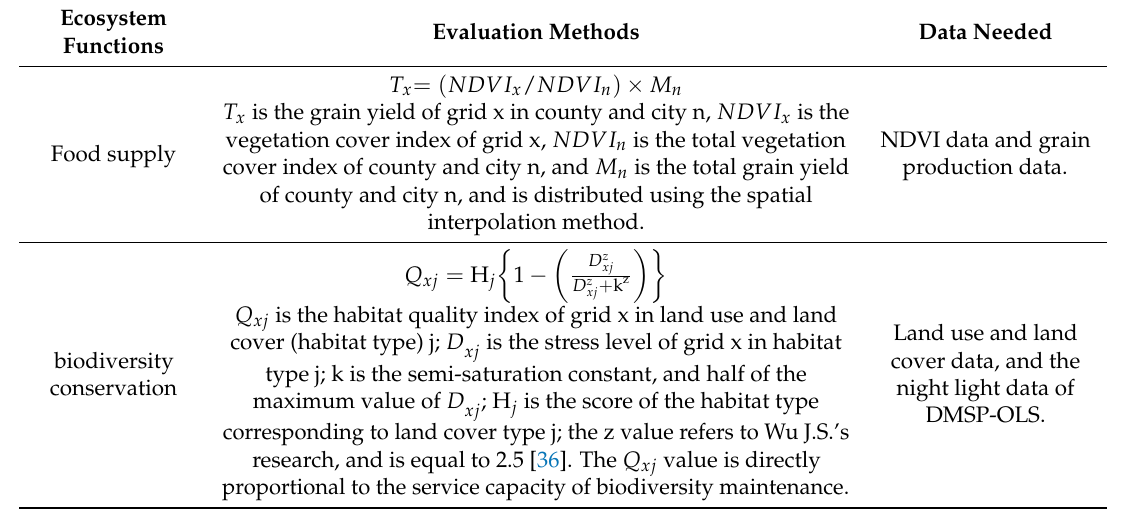
Table 1. Assessment methods and required ecosystem function data .